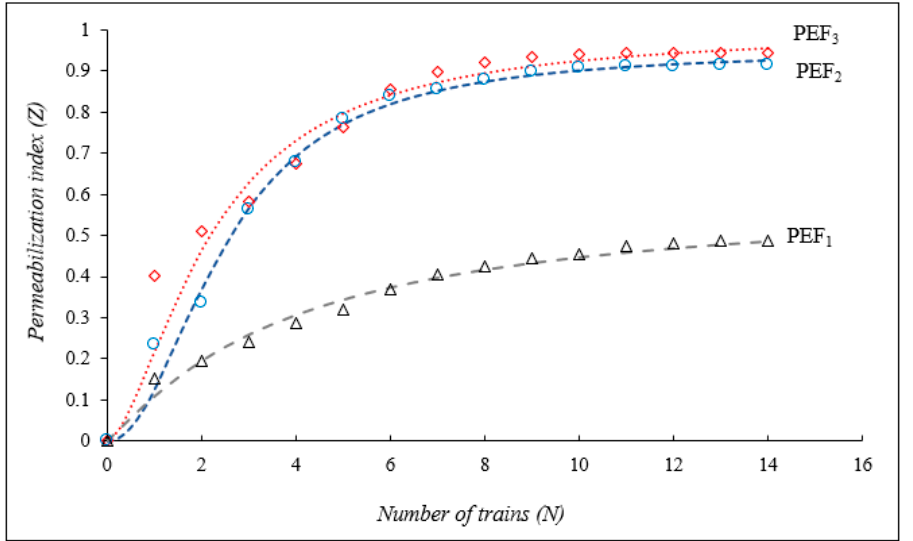
Figure 1. Permeabilization index Z as a function of number of trains (N) at different electric field strengths (PEF 1 = 1 KV.cm − 1 , PEF 2 = 2 KV.cm − 1 , and PEF 3 = 2.5 KV.cm − 1 ).